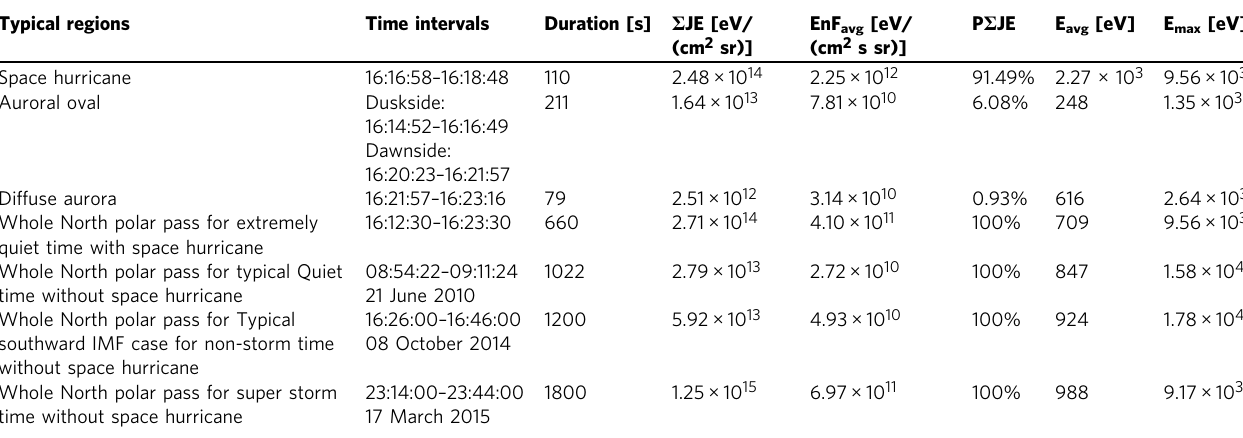
Column1isthetypicalregions,Column2isthetimeintervalsforthetypicalregionsduringtheDMSPcrossings,Column3isthedurationinsecondsofthetimeintervalsshowninColumn2,Column4is the time integrated total electron energy fl ux ( Σ JE), Column 5 is the average electron energy fl ux (EnF avg ), Column 6 is the percentage of Σ JE (P Σ JE), Column 7 is the electron average energy (E avg ), Column 8 is the maximum electron energy (E max